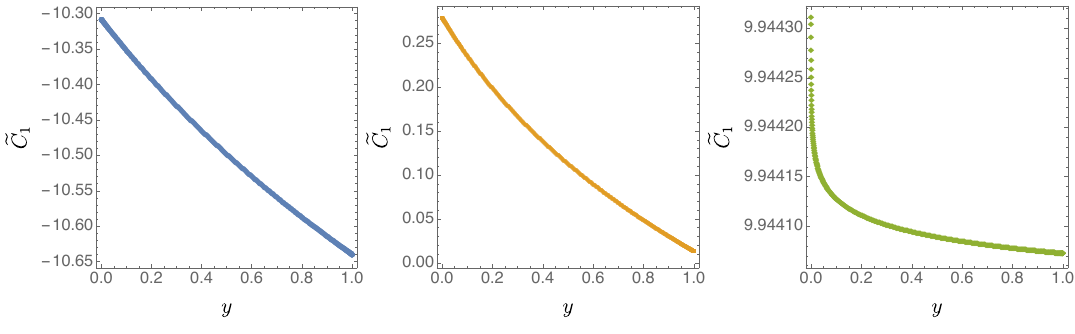
Figure 3 . The plots of e C 1 ( y ) as a function of y , for di(cid:11)erent (cid:12)xed values of have (cid:26)=N 2 (cid:25) 3 : 7 ; 1 : 2 ; 6 (cid:2) 10 (cid:0) 12 . As b